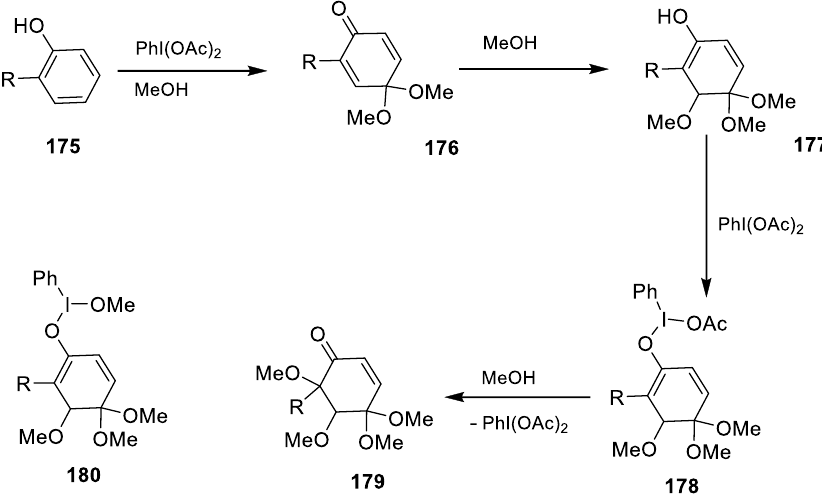
Figure 23. Plausible mechanism for the oxidative dearomatization.